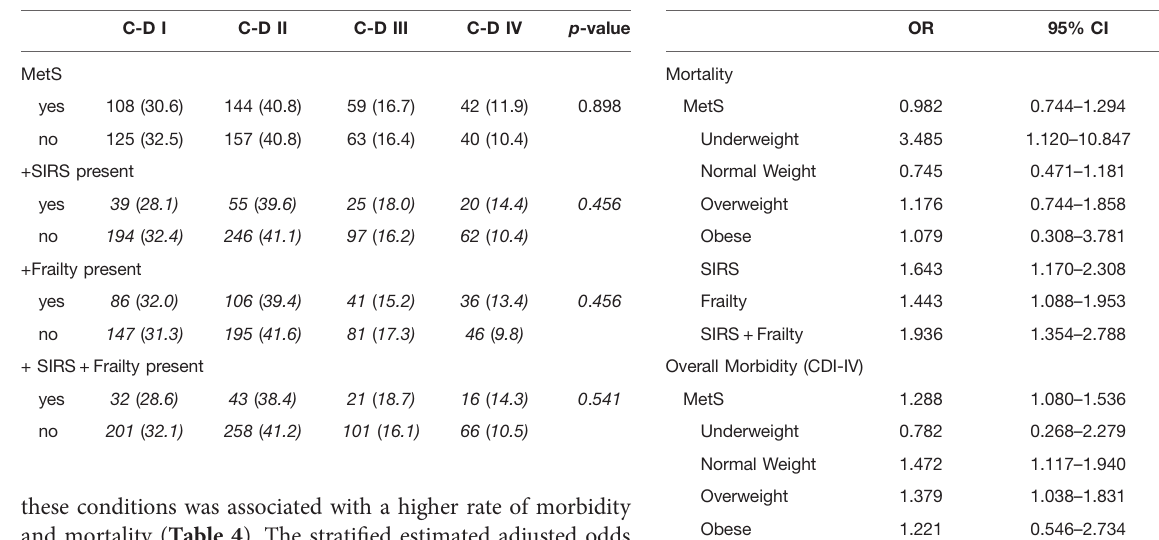
TABLE 4 | Comparison of Clavien – Dindo complications and MetS, SIRS, and Frailty.